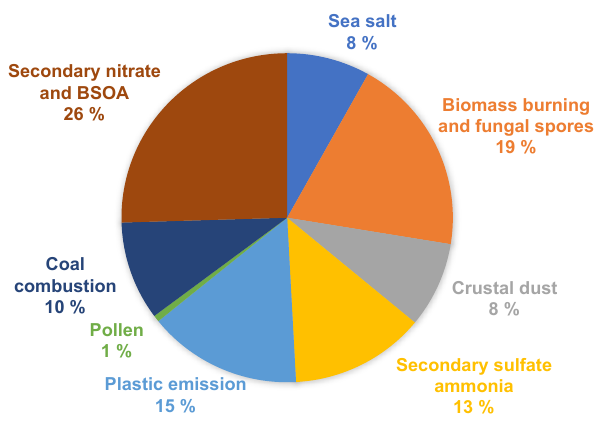
Figure 11. Contributions of different sources to organic carbon (OC) in marine aerosols over the East China